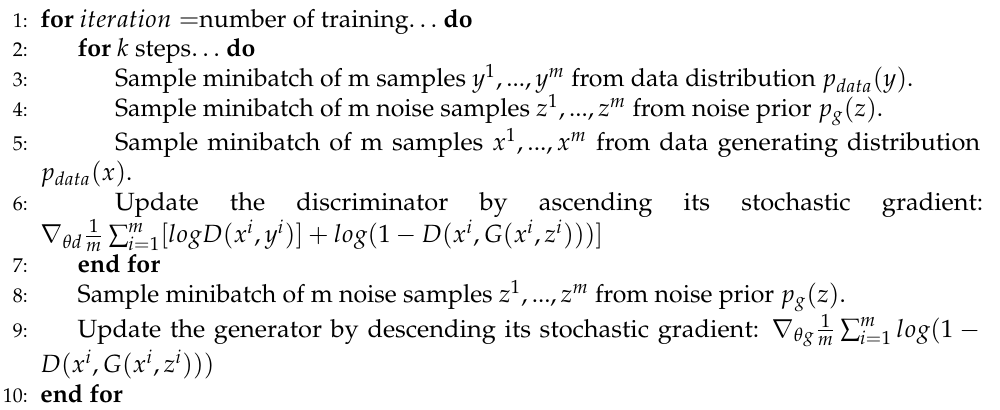
Algorithm 1 Pseudo code of training of Pix2Pix GAN. k is the number of network updates per training